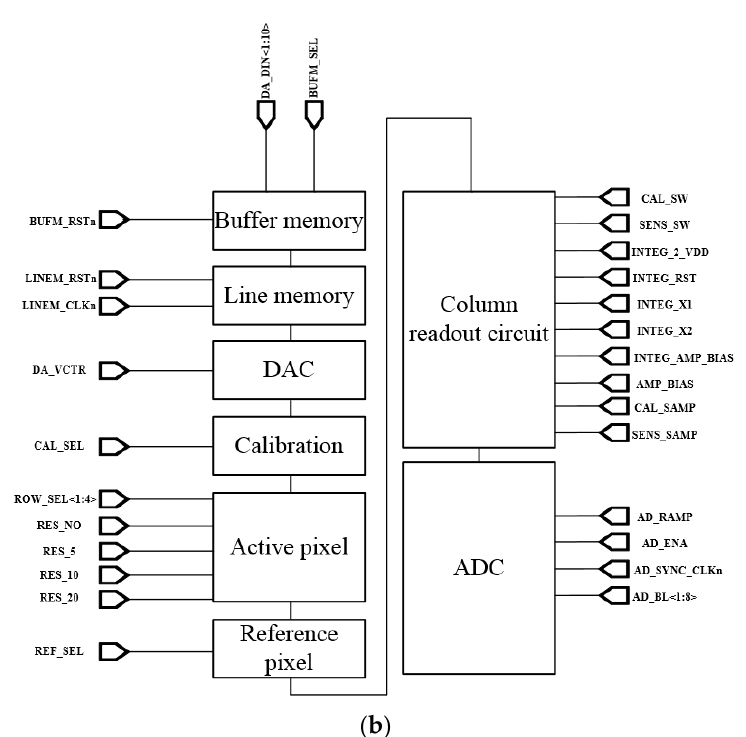
Figure 4. ( a ) Layout of designed readout circuit ( b ) each column block diagram of designed chip. DAC: digital analog converter; ADC: analog digital converter.